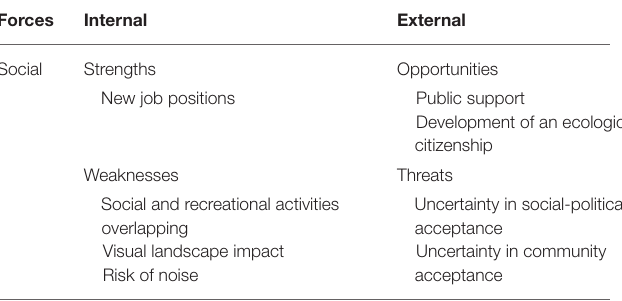
TABLE 1 | SWOT analysis of social factors.